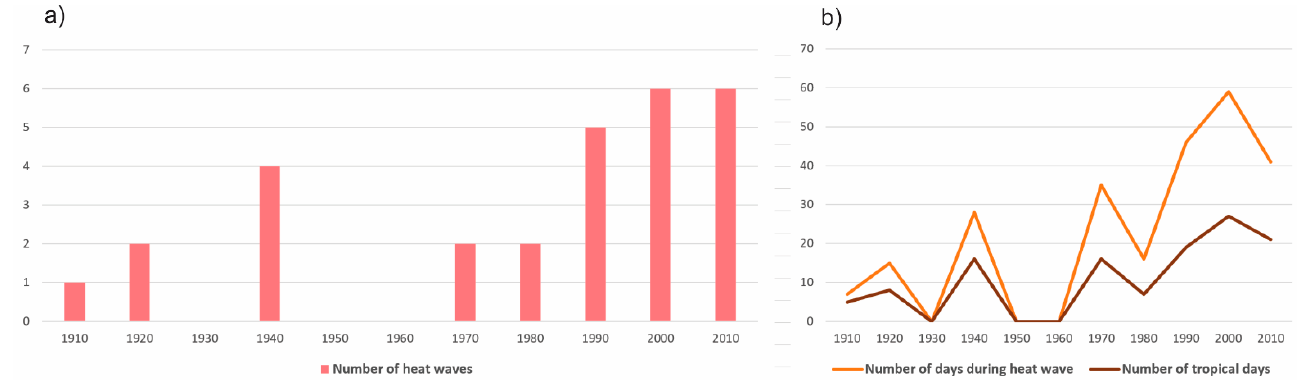
Figure 1. Heatwaves in The Netherlands since 1901. ( a ) Number of heat waves in The Netherlands per decade, ( b ) the number of days during heat waves as well as the number of tropical days (source: https://www.knmi.nl/nederland-nu/klimatologie/lijsten/hittegolven) .